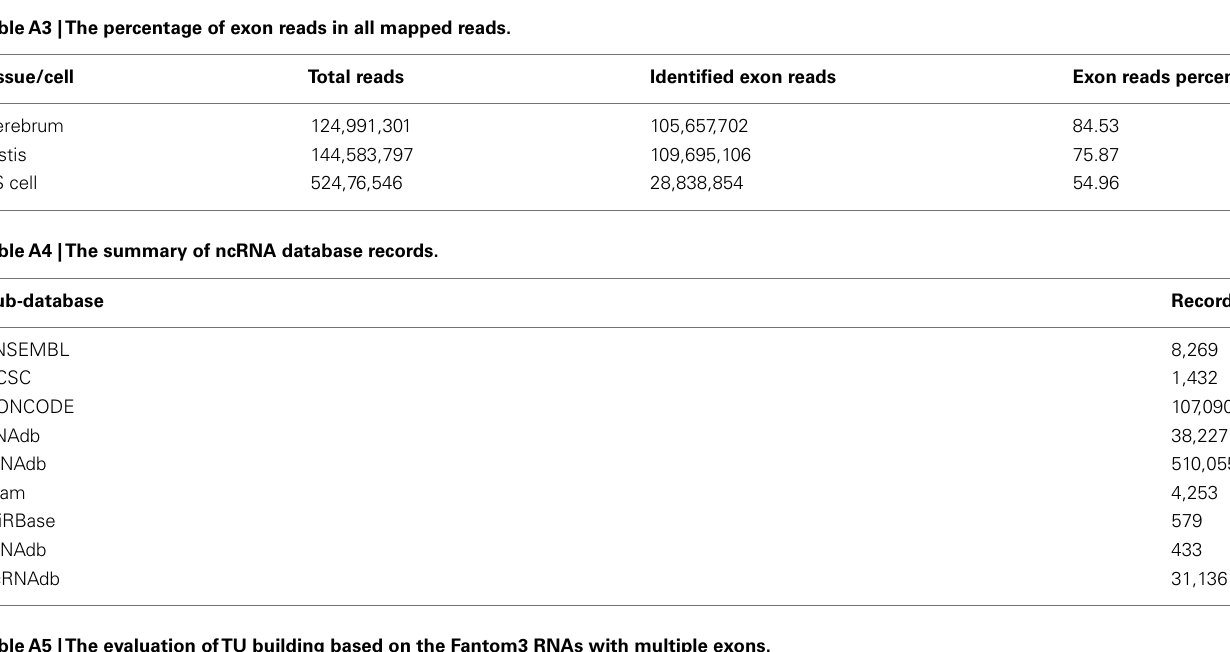
TableA5 |The evaluation ofTU building based on the Fantom3 RNAs with multiple exons. Sample